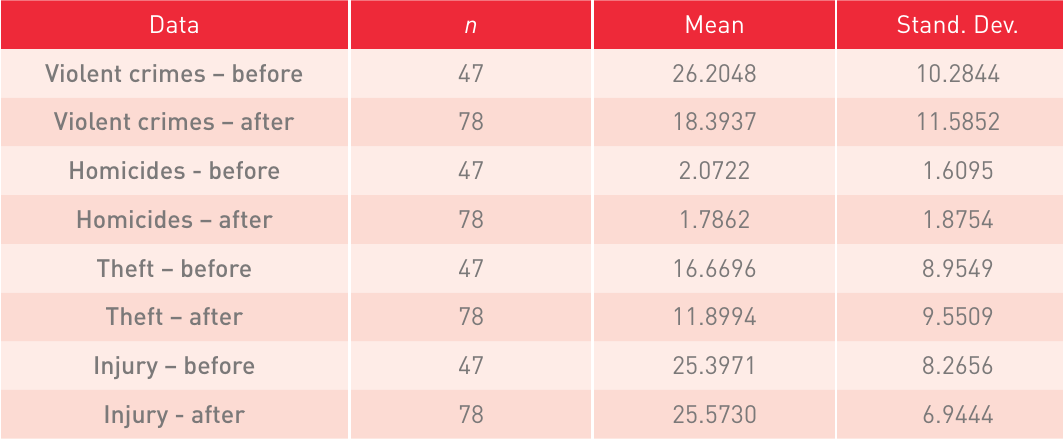
Descriptive Statistics for Mariana dataset